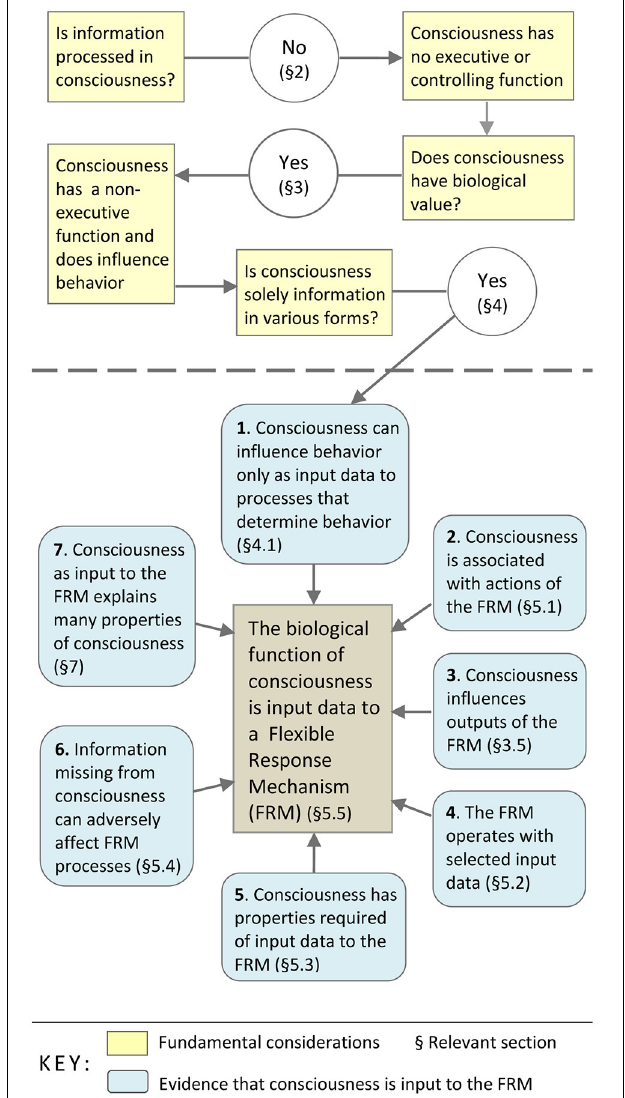
FIGURE 1 | Establishing that consciousness is input to a mechanism which generates thoughts, intentional actions, plans, decisions, and so